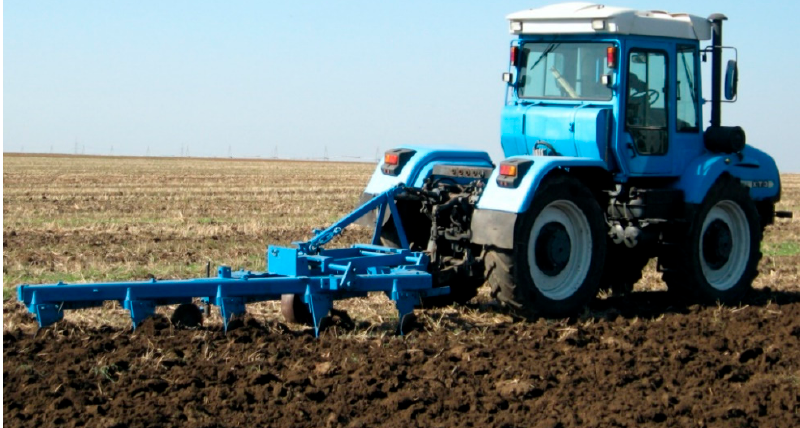
Figure 2. Soil bulk density measuring kit.